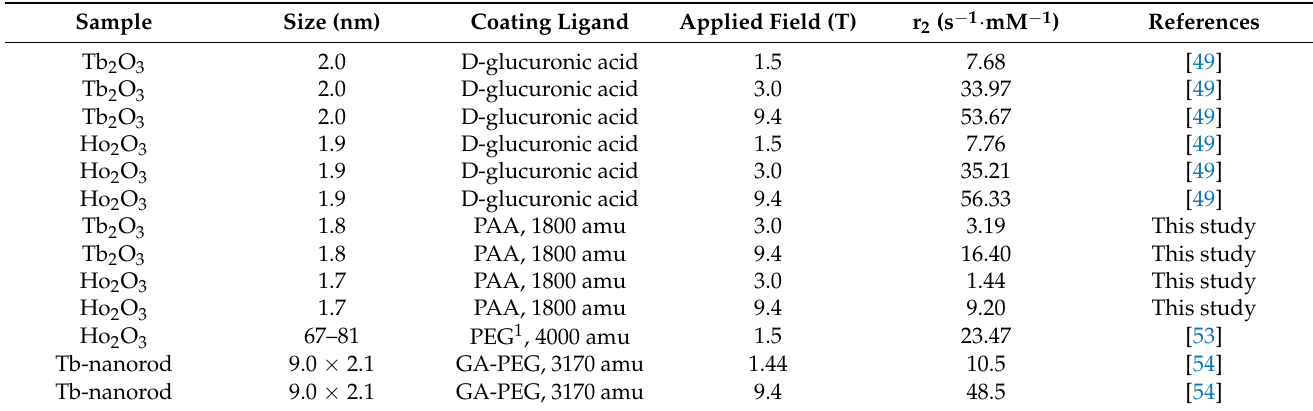
Table 2. Comparison of r 2